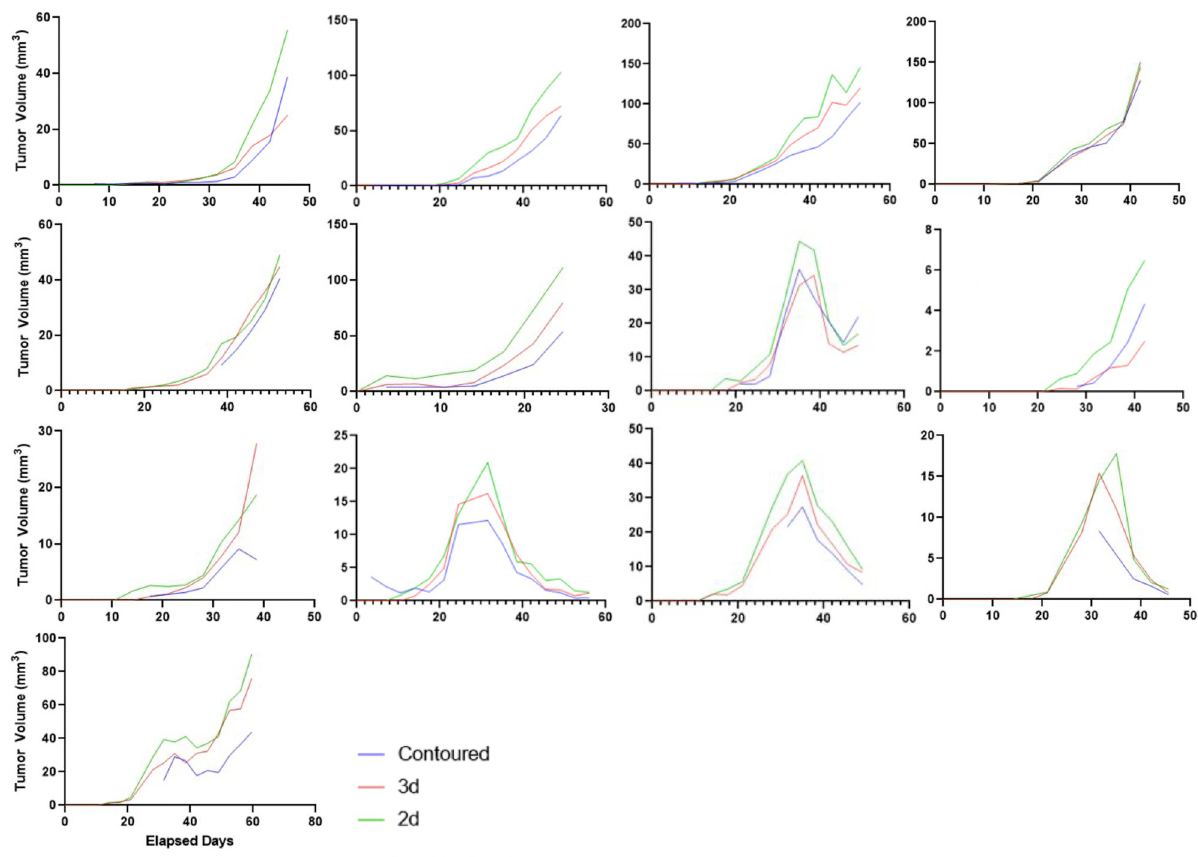
Fig 10. Plots of tumor volume tracking for 13 contoured sample tumors featuring contoured (blue line), 3D approximated tumor volume (red line) and 2D approximated tumor volumes (green line). The x-axis represents elapsed days while the y-axis expresses tumor volume in mm 3 . The plots illustrate consistent tumor volume overestimation for 2D approximated tumor measures while that of 3D more closely approximated the contoured volume.